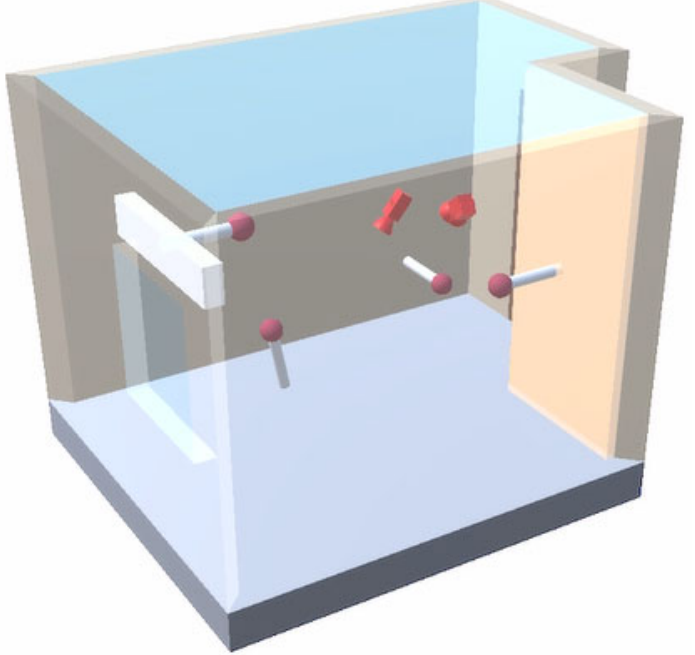
Figure 3. Three-dimensional model of Division 02 with all elements, photos, and annotations found meaningful for the waste audit process (screen shot from BIMeo software) [93].